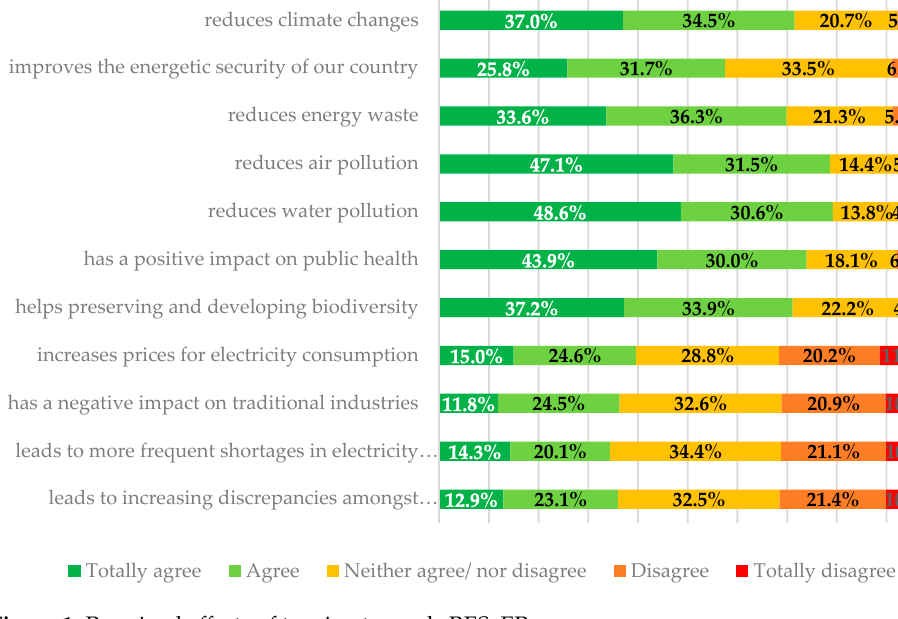
Figure 1. Perceived effects of turning towards RES–EP. As seen in Figure 2, we also assessed the main overall concerns that respondents had regarding society, the economy, and the energy sector. These were also measured indi- vidually on a modified 5-point Likert scale.